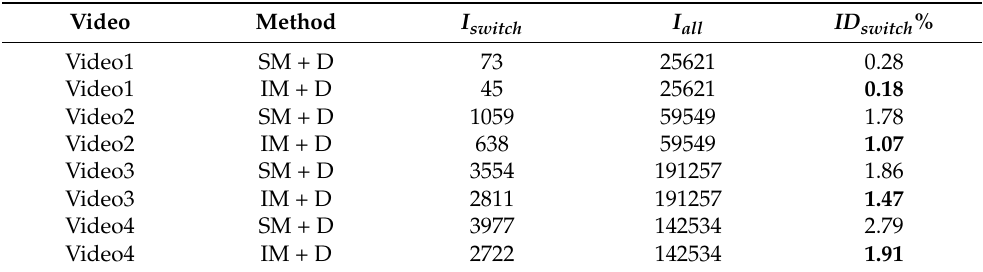
Table 5. The tracking evaluation indicators of the particles. “SM + D” is the experimental results of the standard Mask R-CNN and Deep SORT. “IM + D” represents the experimental results of the improved Mask R-CNN and Deep SORT.